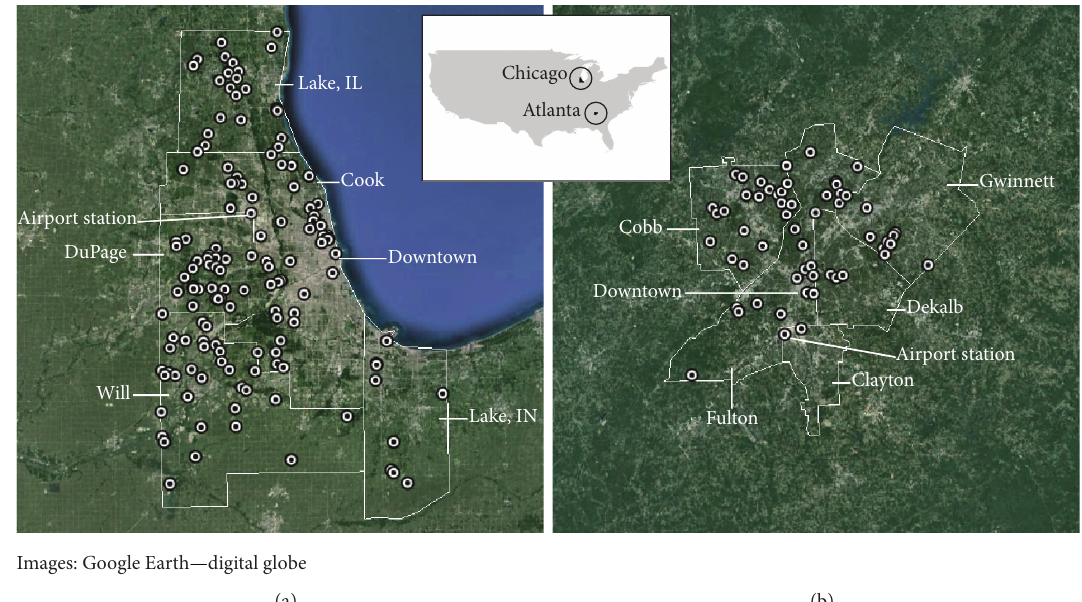
Figure 1: The five-county study areas of Chicago (a) and Atlanta (b) are shown. Weather stations (including the airport stations) are shown with dotted